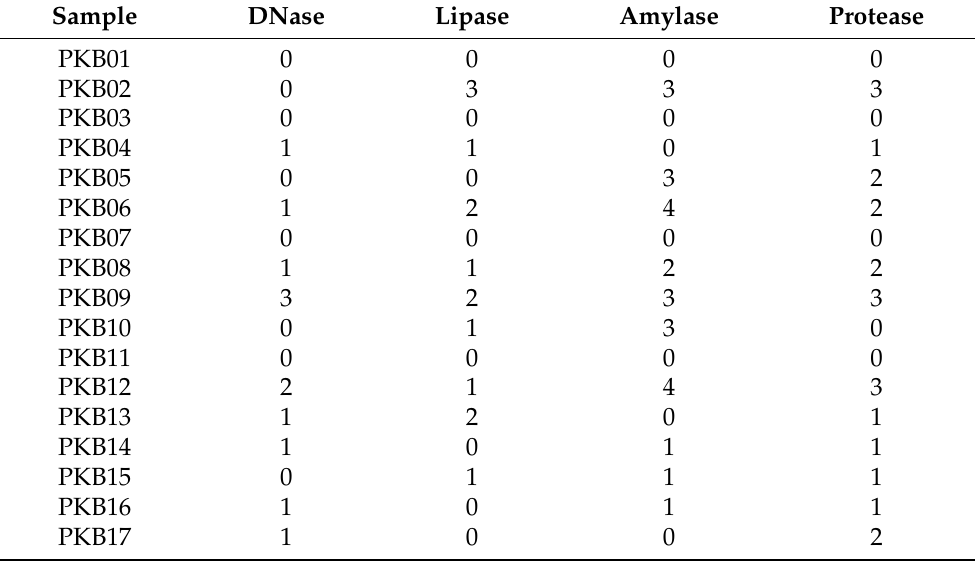
Figure 5. Kriging mapping of positive activities in different cultures: ( a ) DNase, ( b ) lipase, ( c ) amylase, and ( d ) Protease. Table 3. Positive activities in different media